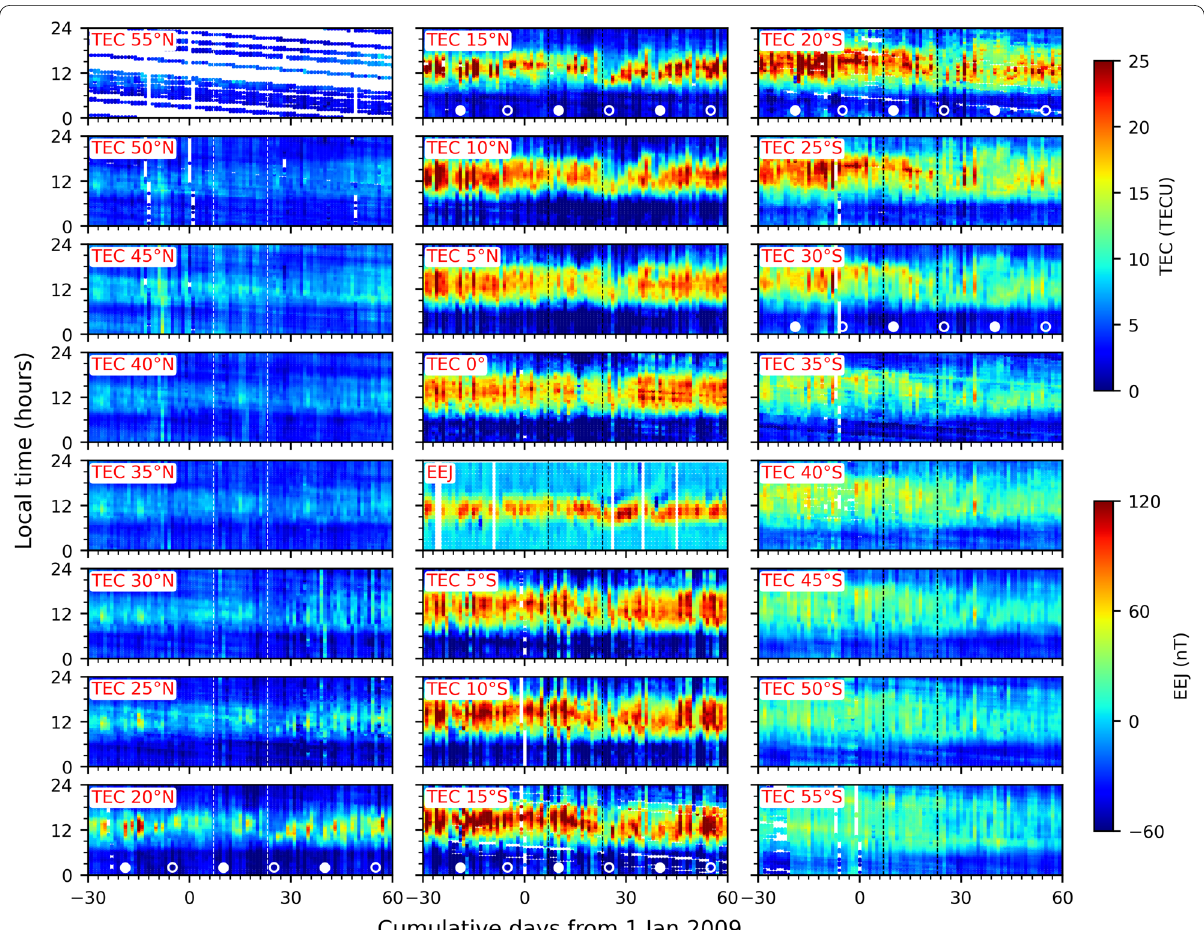
Fig. 3 The vertical TEC and EEJ strength data as a function of cumulative days from 1 January 2009 and solar local time over the eastern Asia– Australia sector at different geomagnetic latitudes. The vertical dashed lines are the same as those in Fig. 2a. The white dots and circles indicate the dates of the full moon and the new